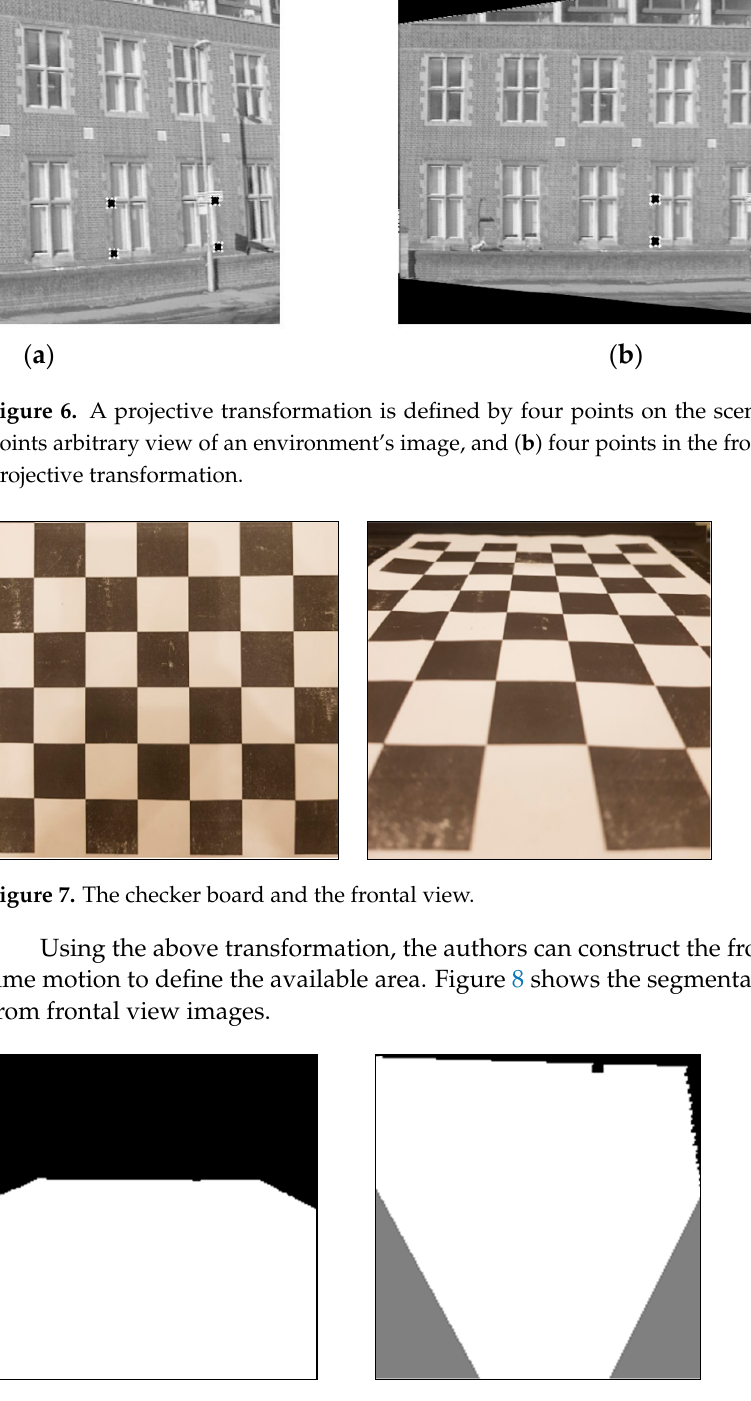
Figure 9. The mobile robot’s bird view. 3.2. Path Planning Based on the generated frontal plane, the authors will construct a moving path using a traditional A* algorithm [17]. Firstly, the authors create a collision-free area by scalding up the unavailable place. After that, the image will be divided into grid cells. The current position is determined at the bo tt om center of the picture. The authors calculate the centers of each cell and use them for the path planning process in Figure 10.